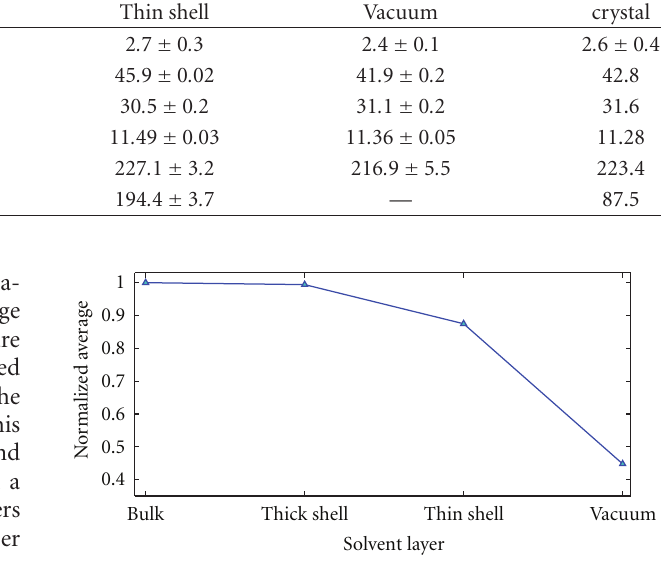
Figure 4: Normalized average of hydrogen bonds of ubiquitin in various aqueous environments. The sum of protein-protein and protein-water bonds, normalized to the value for the bulk system, is shown. The statistical error is ± 0 . 02, Table